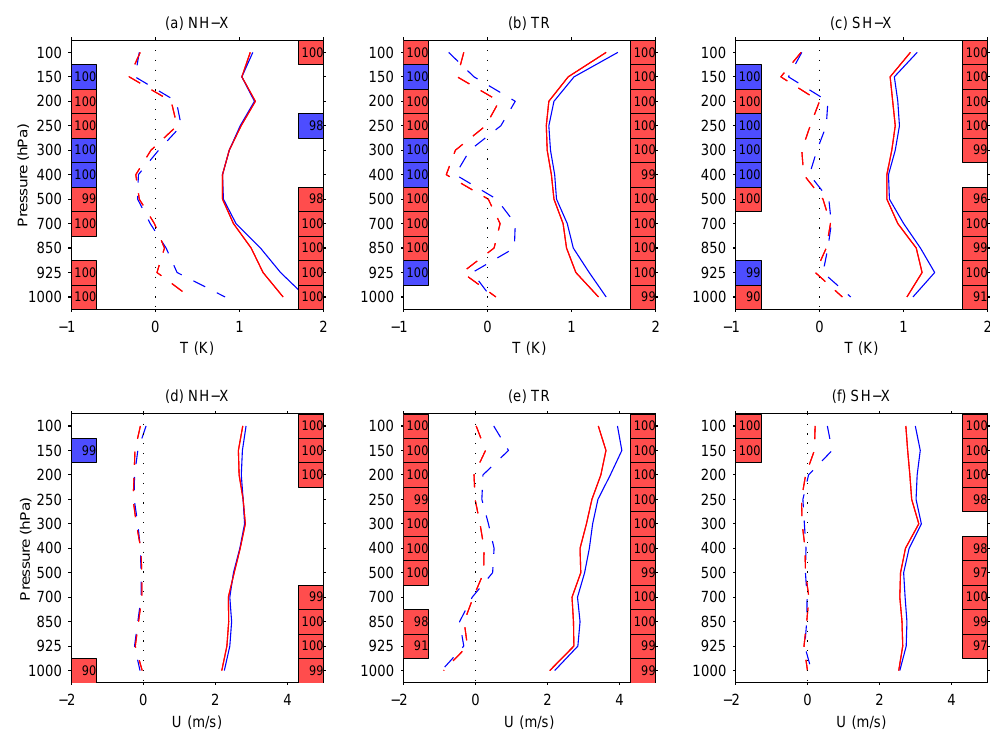
Fig. 3. The standard deviation (solid curves) and bias (dashed curves) for the 6h forecasts produced by the EnVar (red) and 4D-Var (blue) experiments for the February/March 2011 period relative to radiosonde observations. The results are shown for temperature (upper panels) and zonal wind (lower panels) for the northern extra-tropics (left panels), tropics (middle panels) and southern extra-tropics (right panels). The small shaded squares on each side of the panels indicate the significance level of the differences between the statistics (bias for left side, standard deviation for right side) and the color indicates which experiment has the better